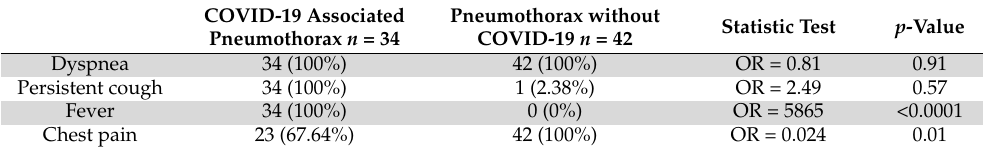
Table 4. Patients’